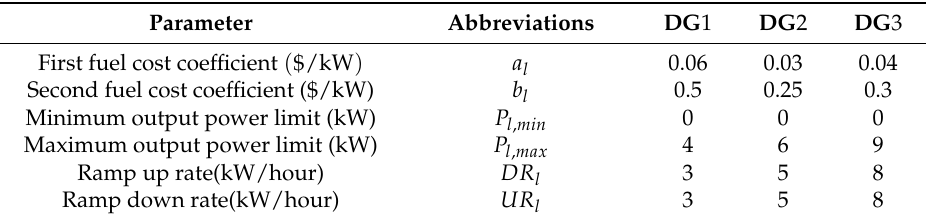
Table 1. Data for diesel generator cost parameters.